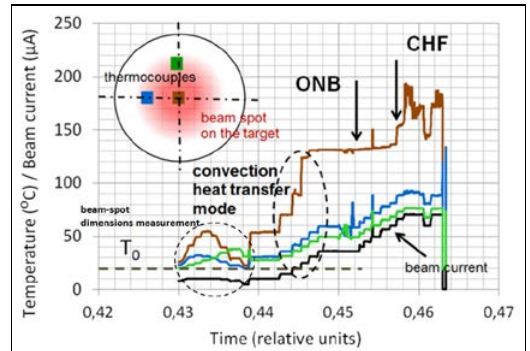
Fig. 6. Typical behavior of temperature in thermocouples located in various positions on the beam spot area during the irradiation by a proton beam.